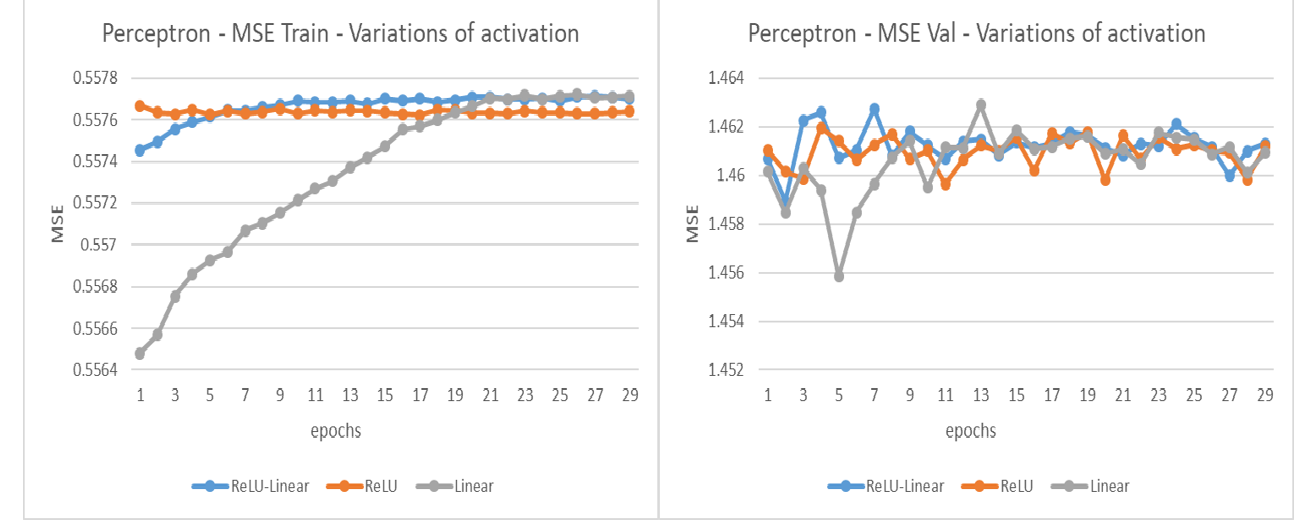
Figure 12. Comparative test results on the variation of func. Activation. Source: Own elaboration. Soc. Sci. 2021 , 10 , x FOR PEER REVIEW